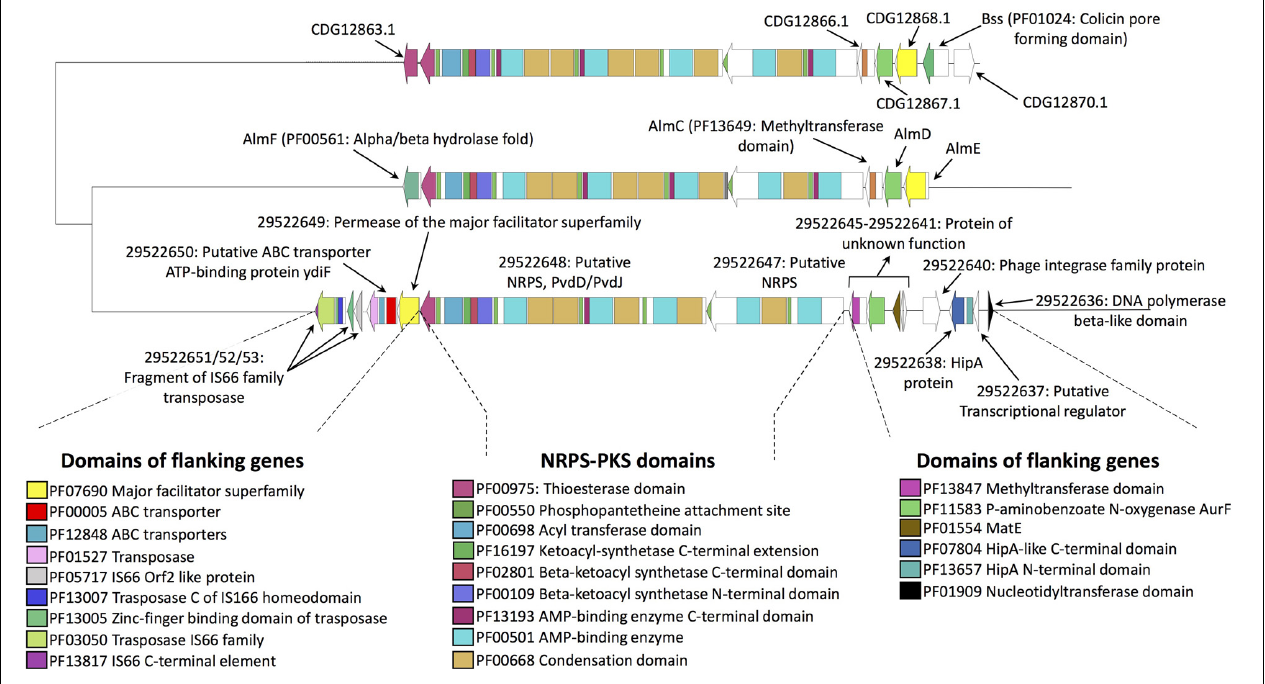
FIGURE 2 | Genomic region containing the putative biosynthetic cluster in the Ca Gg endobacterium. The cluster contains a NRPS-PKS gene and a neighboring NRPS (29522648 and 29522647, respectively). Protein IDs were retrieved from the MicroScope MaGe platform (https://mage.genoscope.cns.fr/microscope/ home/index.php). A similarity was found with the MIBiG reference clusters for the biosynthesis of althiomycin of Serratia marcescens and Myxococcus xanthus (BGC0000955.1 and BGC0001415.1, respectively). The core biosynthetic genes are linked with dashed lines. Sequence alignment, as well as the distance tree and the PFAM domains prediction, were obtained with